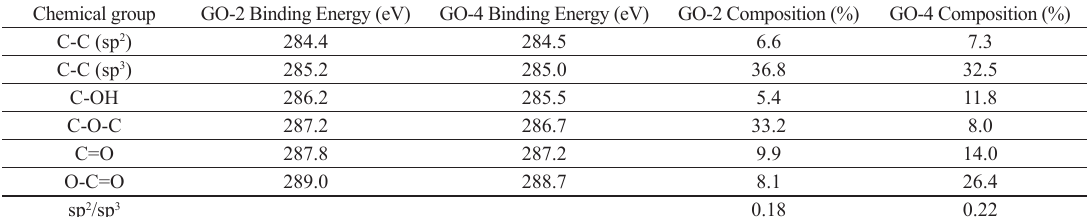
Table 2. X-ray photoelectron spectroscopy analysis of the functional group’s atomic composition in GO-2 and GO-4 using high-resolution XPS C 1s spectra fitting. Chemical group